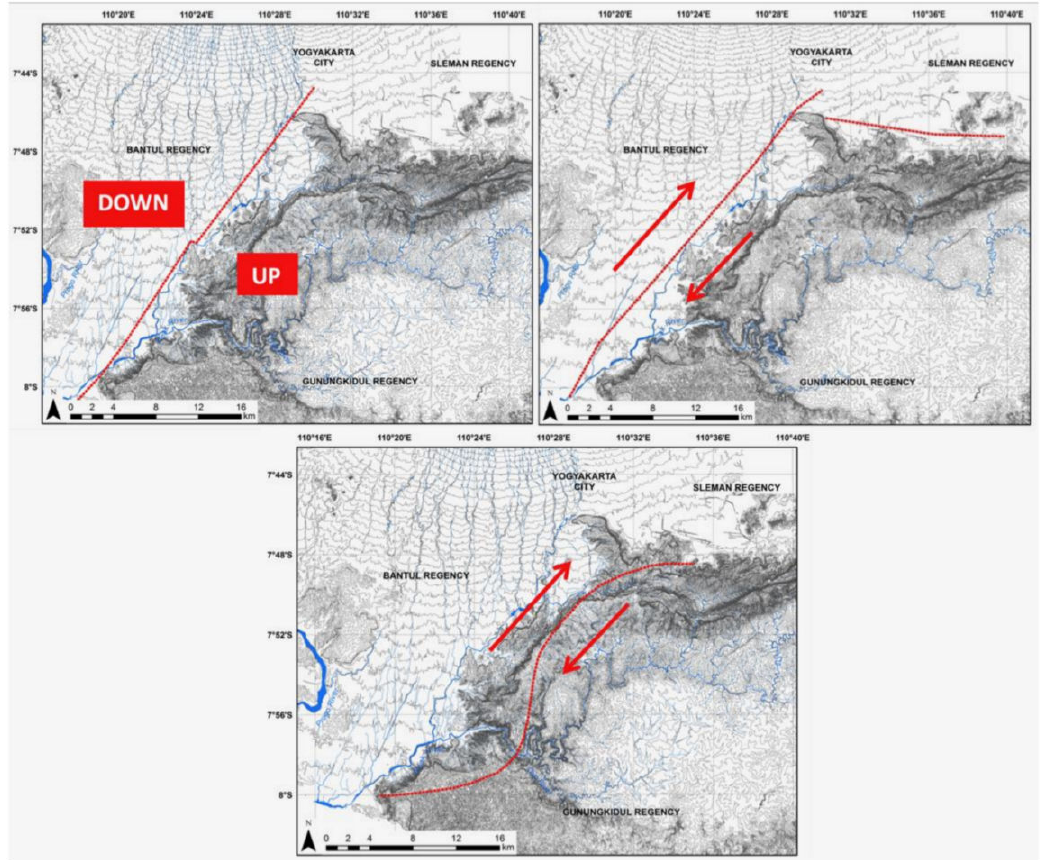
Figure 4. The normal fault of Opak Fault (modified from [5]) ( top left ); Strike slip fault mechanism of Opak Fault (modified from [6]) ( top right ); the sinistral fault of Opak Fault (modified from [7] ( bottom